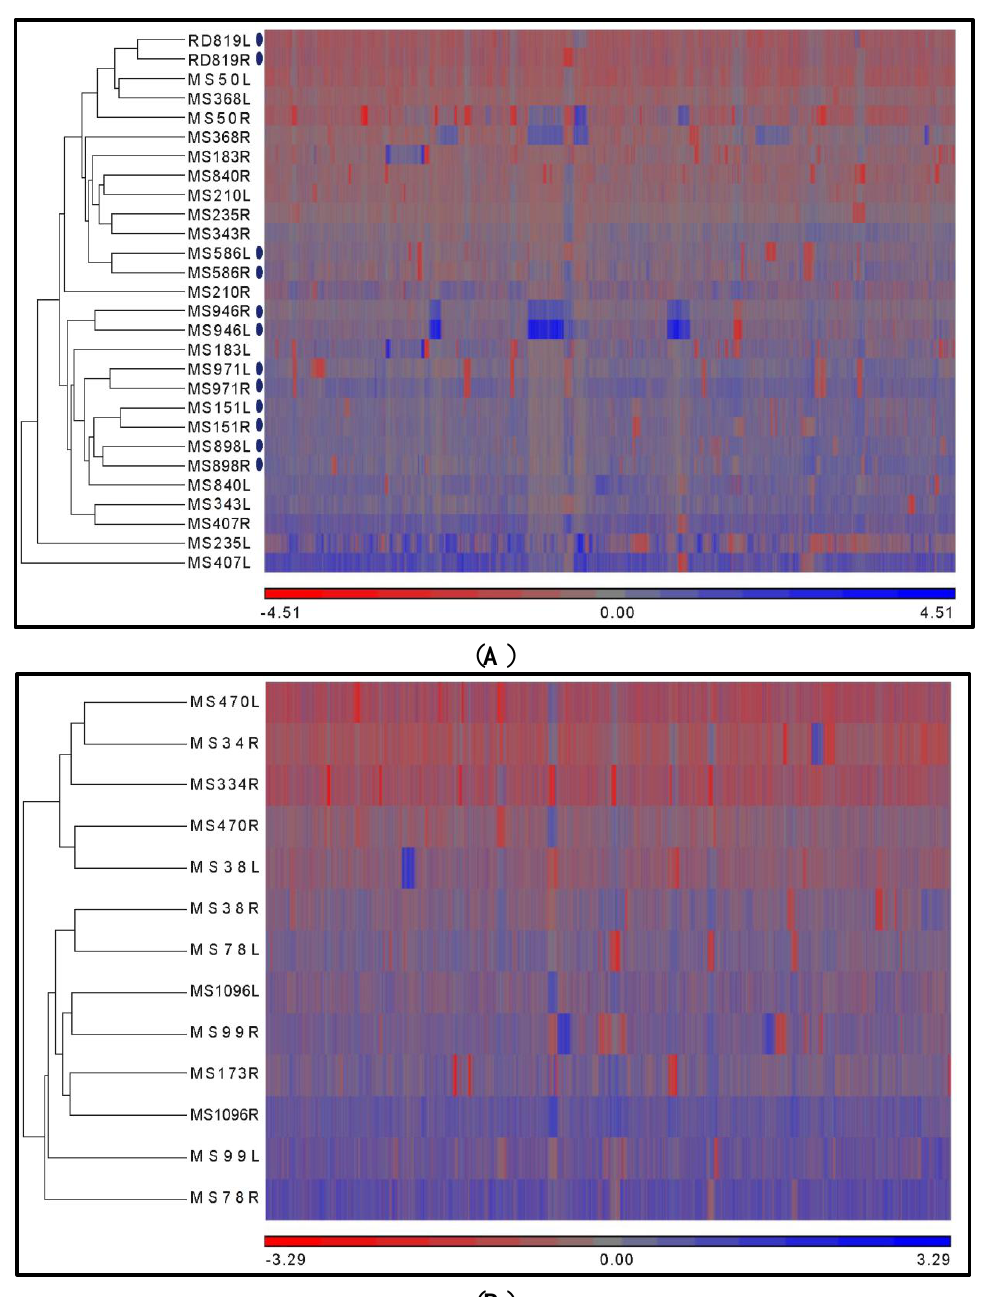
Figure 3. Hierarchical clustering of copy number summary from chromosome 1 to 22. (Heat map: red represents gene losses, blue represents gene gains and grey represents unchanged gene states). Blue oval symbols denote tumors from the same prostate that remain closely clustered. ( A ) Multifocal prostate cancers; ( B ) Unifocal prostate